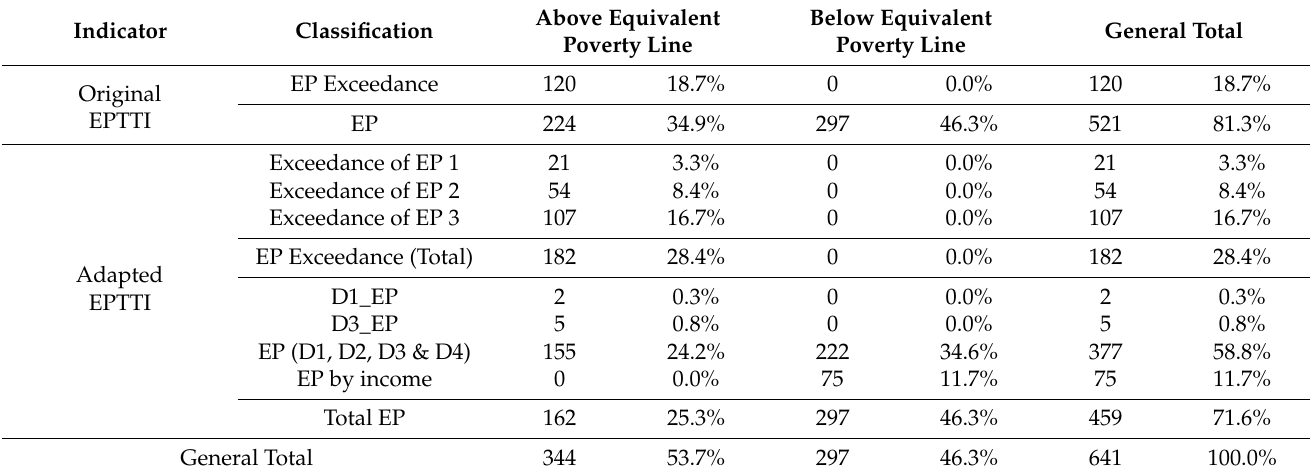
Table 9. Results of Original and Adapted EPTTI indicators, considering Chile’s Equivalent Poverty